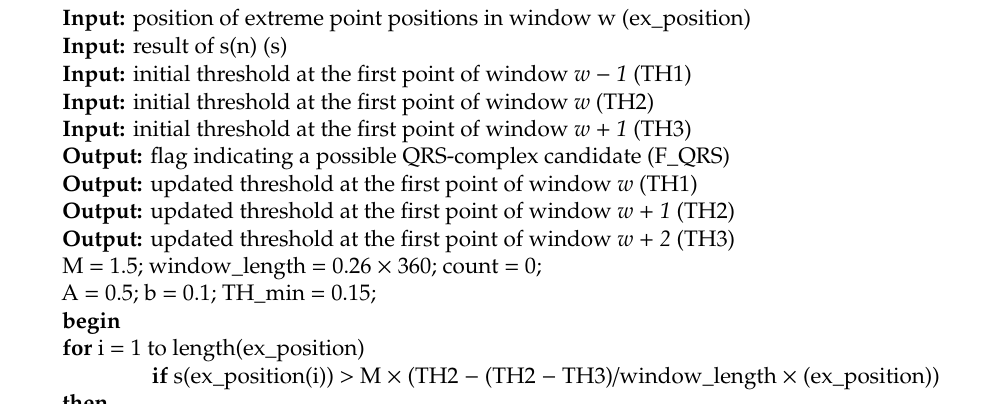
Table 1. The algorithm of the proportional-derivative PD control-based threshold adjustment in window